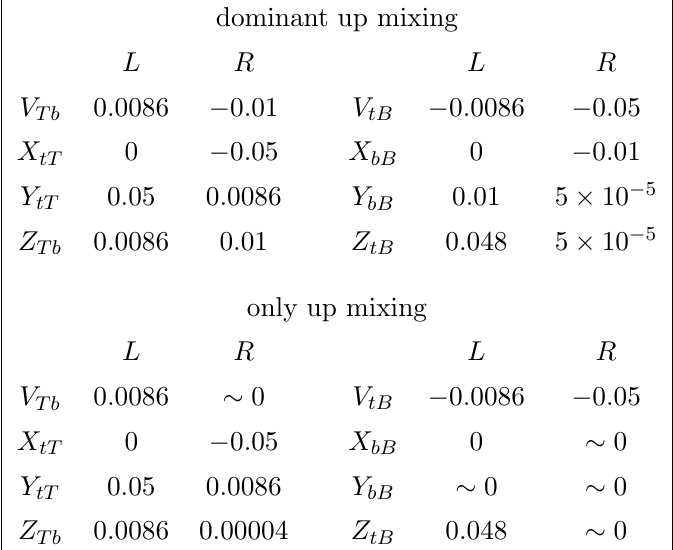
= 0 : 05, s d = 0 : 01 for m T;B = 1 TeV R R = 0 : 05, s d (cid:24) 0 ( s u = 0 : 0086, R R L